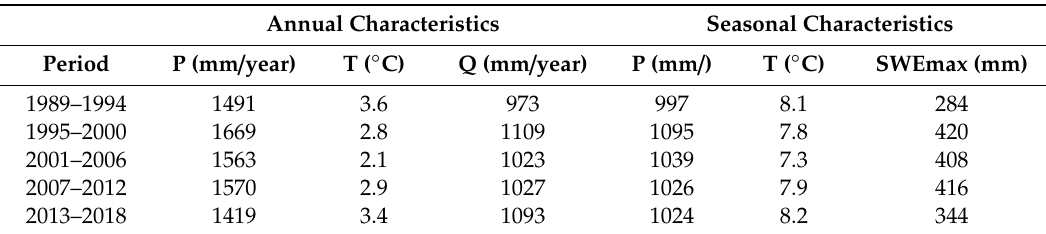
Table 1. Mean annual and seasonal characteristics of precipitation (P), air temperature (T), runo ff (Q) and snow water equivalent (SWE) in the selected periods. Seasonal characteristics of P and T represent the period from April to October, SWEmax is the mean of SWE maximum in each